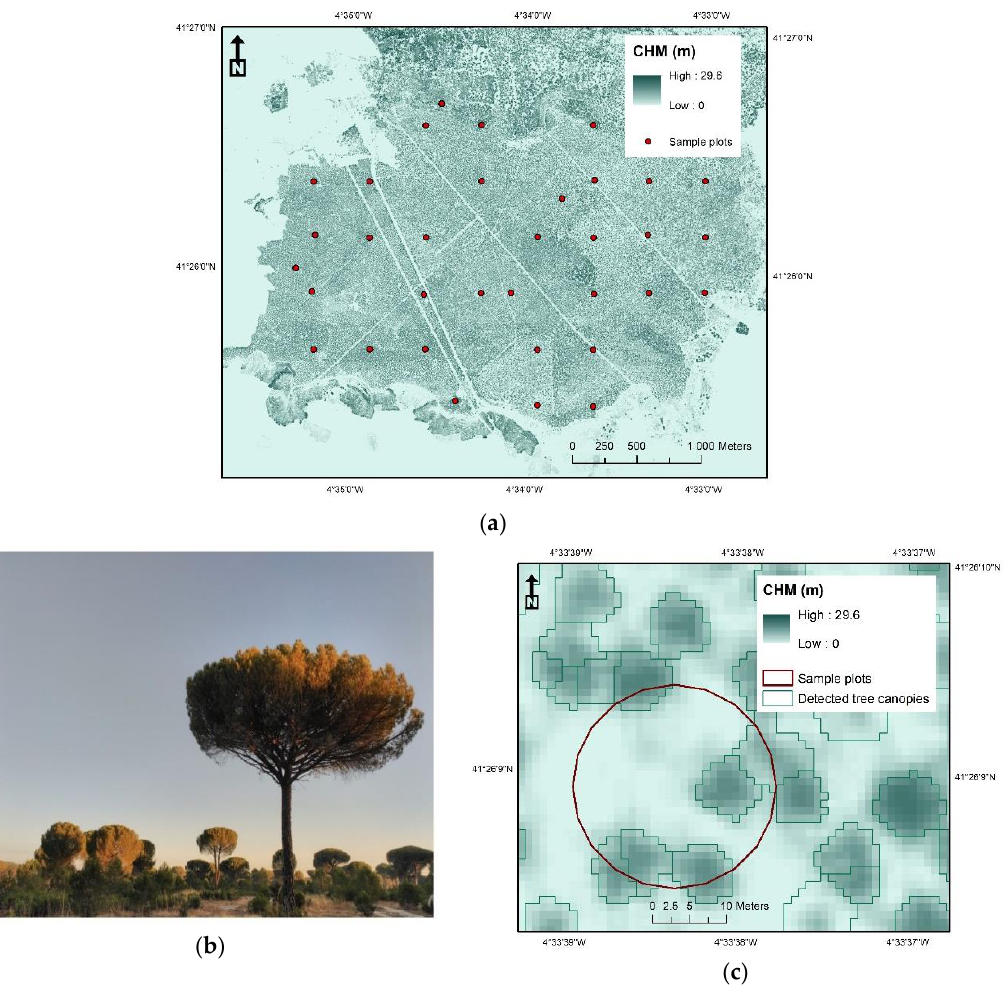
Figure 2. ( a ) Study area forest showing the spatial layout of sample plots and the canopy height model (CHM) derived with airborne laser scanning (ALS) data; ( b ) sample plot for one of the 35 plots composing the research experiment; ( c ) CHM and detected tree canopies within a sample plot and the surroundings.